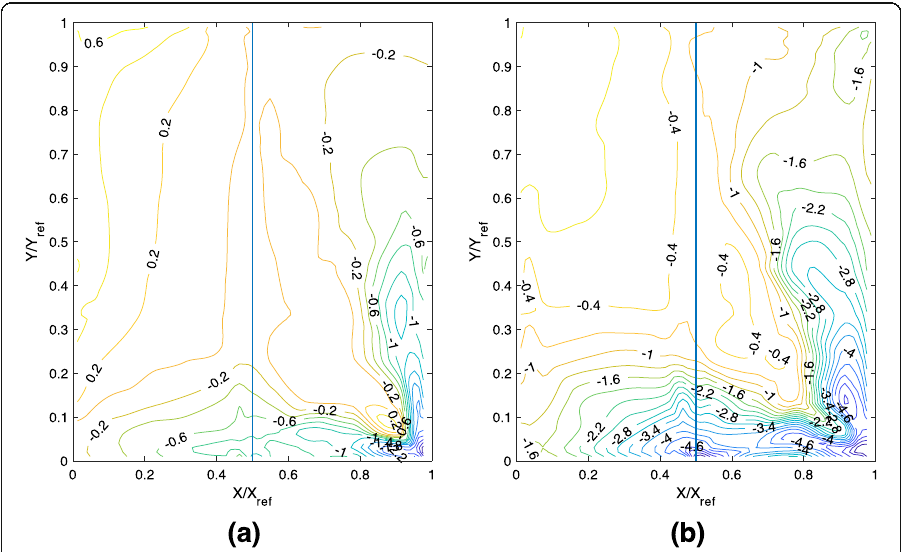
Fig. 14 Contours of roof pressure coefficients ( θ = 45 deg.), for the 4.5 ft. parapet case: ( a ) mean Cps,